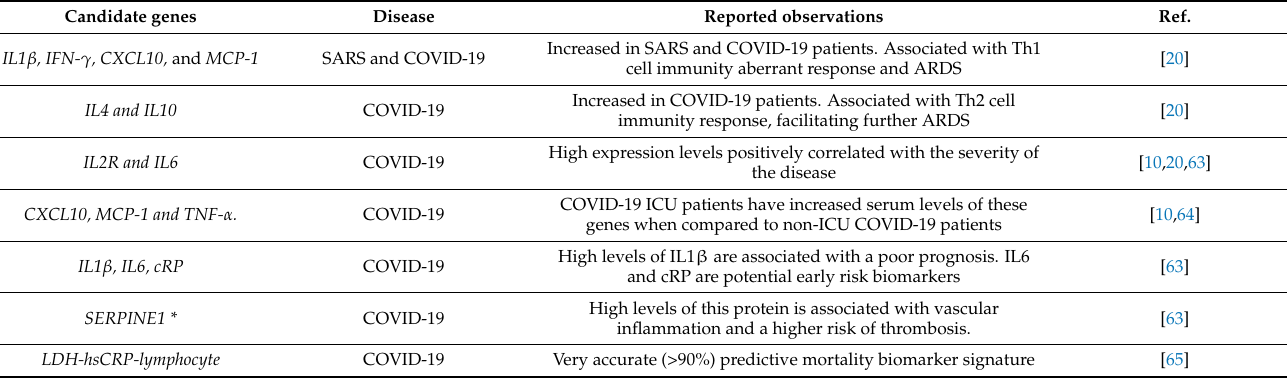
Table 3. Dysregulated genes reported in first COVID-19 hospitalised